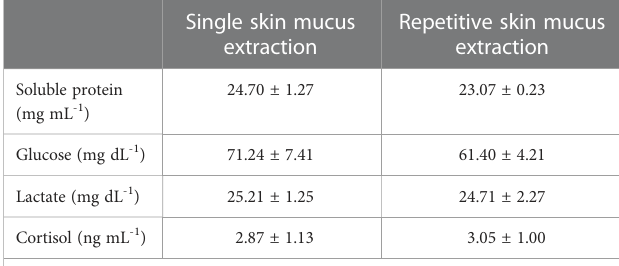
TABLE 2 Plasma biomarkers of gilthead sea bream subjected to single or repetitive skin mucus extractions. Single skin mucus extraction